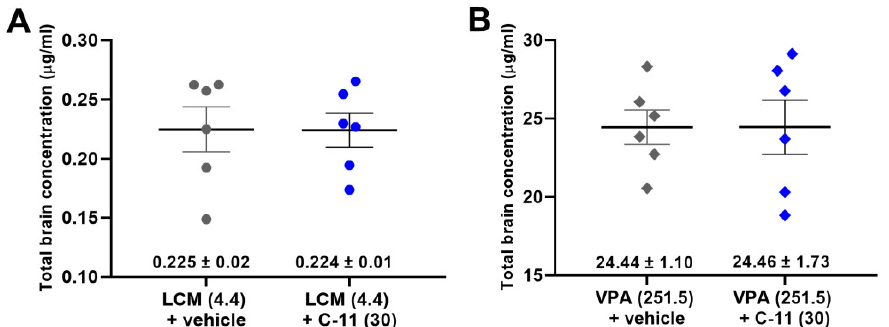
Figure 3. Influence of C-11 on total brain concentrations of LCM ( A ) and VPA ( B ) in mice. Scatter plots represent total brain concentrations of AEDs in µg/mL (as means ± SEM, as the error bars) ( n = 6 mice/group). No statistical significance between the means were observed (unpaired Student’s t test).